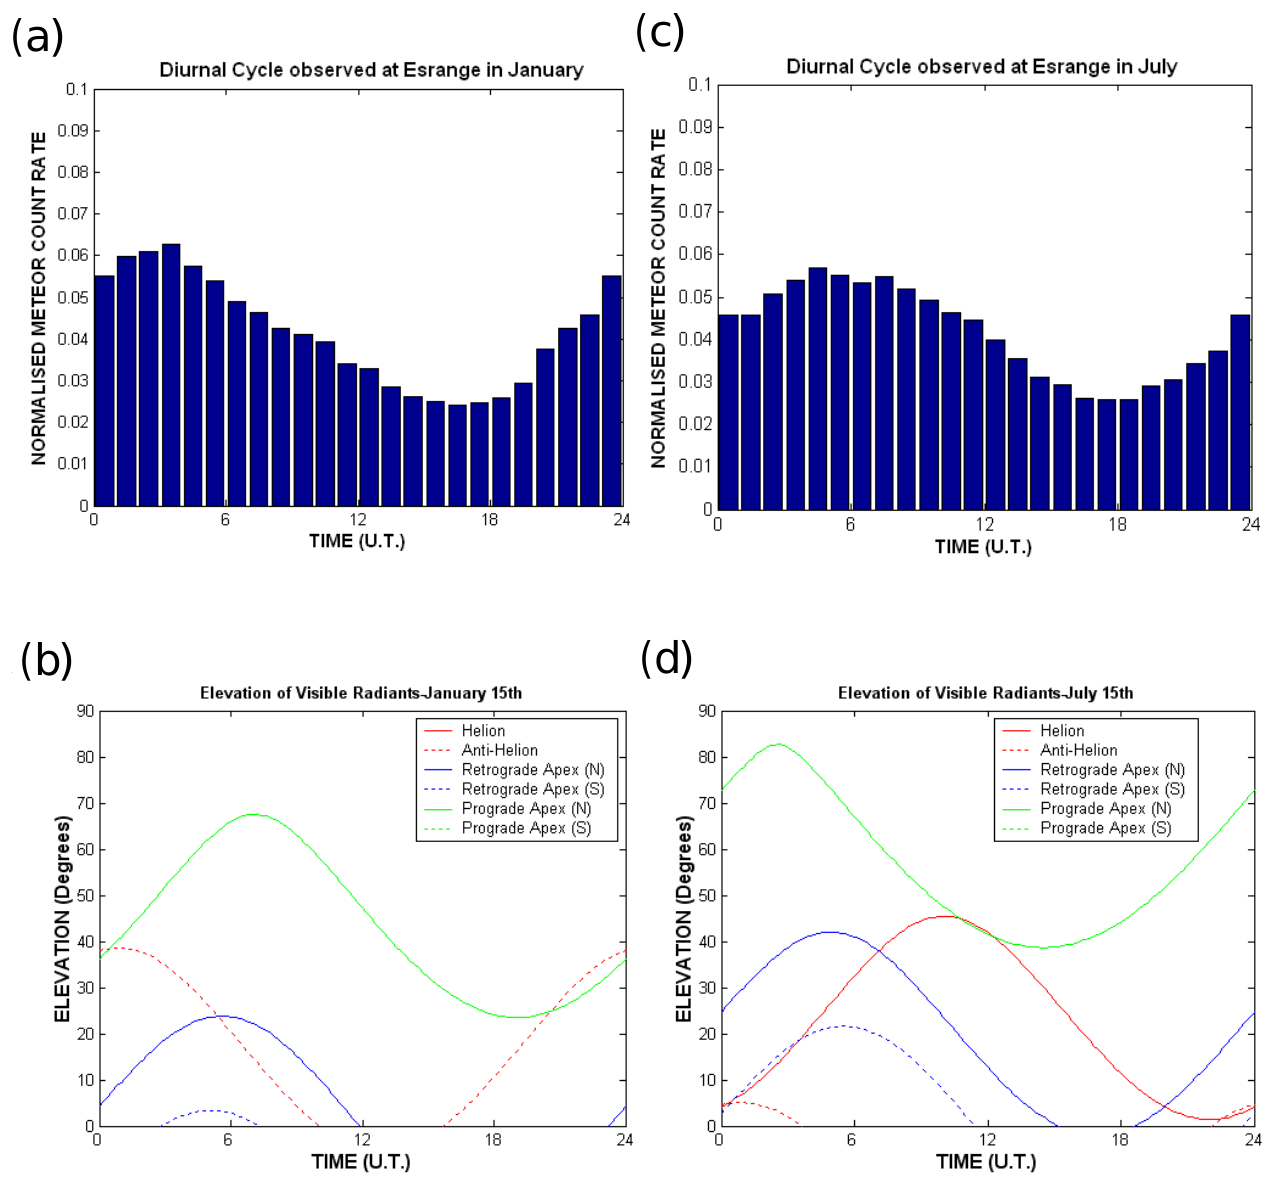
Fig. 8. Hourly meteor count rate observed at Esrange on (a) January 2004 and (b) July 2004 (Note the use of universal time). The elevation angles of the six source regions of the sporadic radiant distribution are shown in (a) for 15 January 2004 and (b) for 15 July 2004.